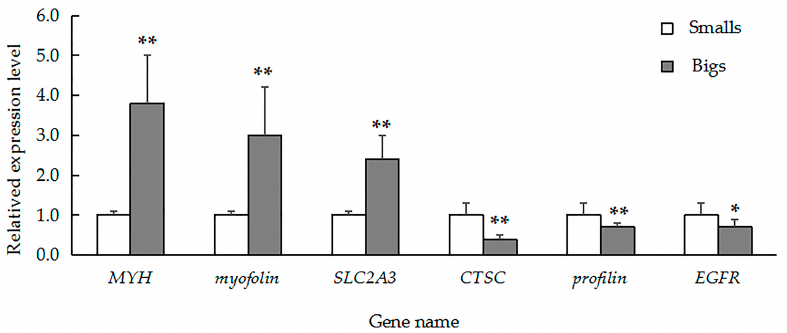
Figure 4. Quantitative real-time polymerase chain reaction (QRT-PCR) analysis comparing relative gene expression among MYH , myophilin , SLC2A3 , CTSC , profilin , and EGFR in large and small specimens of H. discus hannai. Gene expression was normalized to 18S rRNA . The data are expressed as means ± SD ( n = 3). Large specimens, grey bars; small specimens, white bars. Asterisks represent statistically significant differences. * and ** indicate p < 0.05 and p < 0.01, respectively.